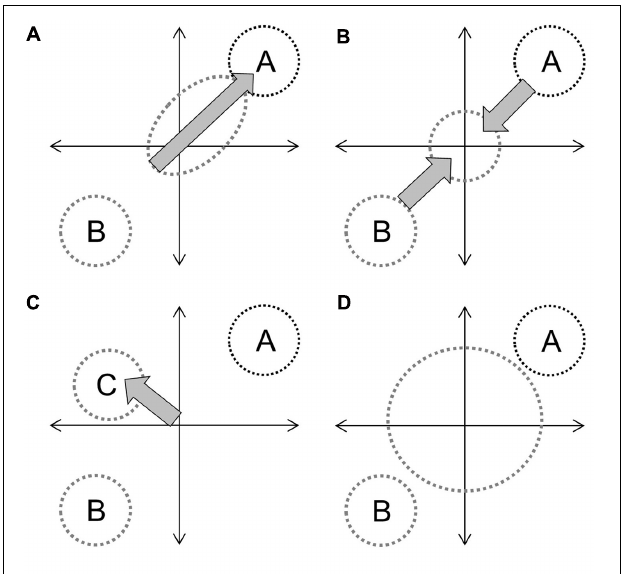
FIGURE 1 | Diagrammatic examples of four hybrid trajectories on an undefined parameter space representing combinations of functional adaptive traits: directional introgression (A) , maintenance as an intermediate group (B) , speciation (C) , and the hybrid swarm effect (D) , which operates under limited or no selection. Circle size indicates overall variability and labels denote defined species. Gray arrows indicate selection, with arrow size representing effect size.